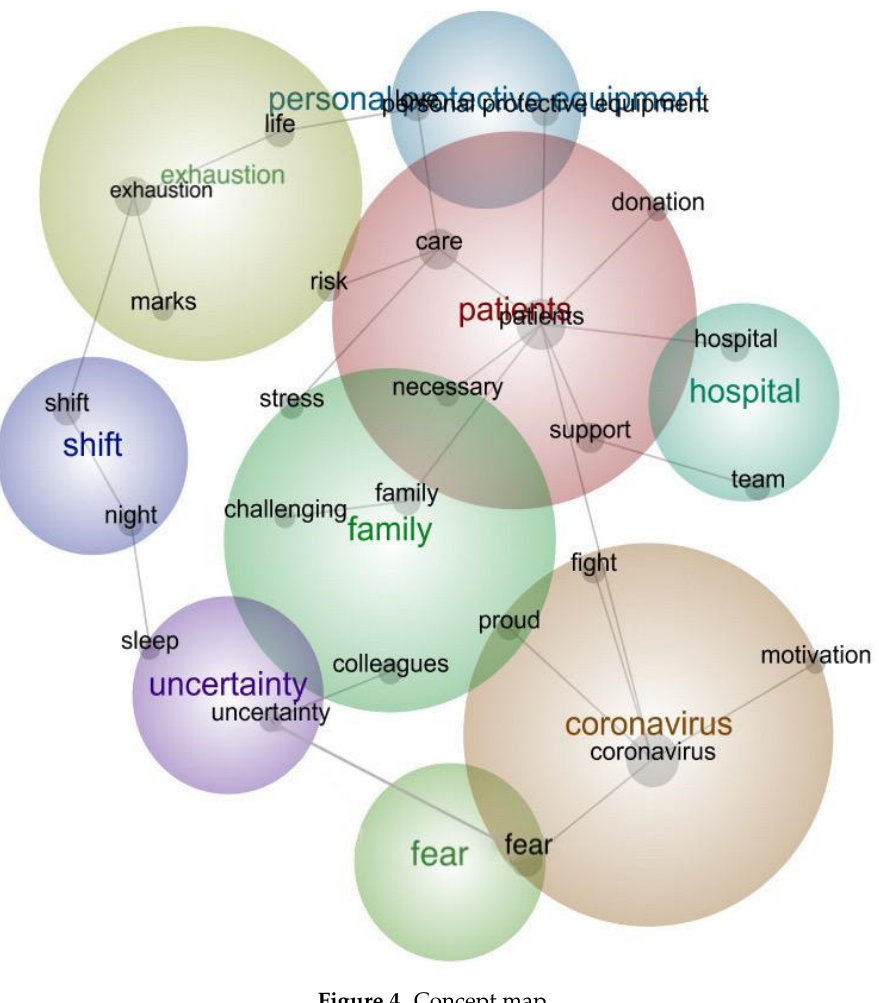
Figure 4. Concept map. Table 1. Main themes, concepts, and relevancy percentages.